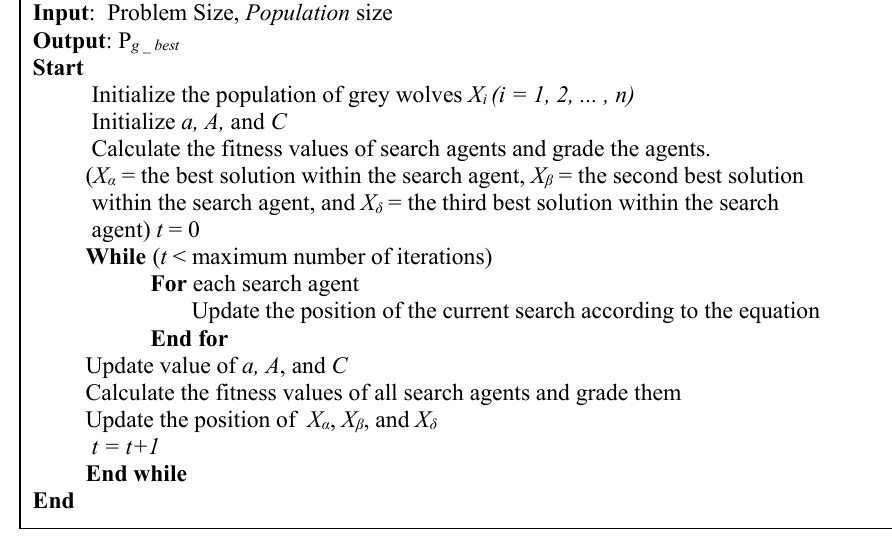
Fig. 2. Pseudo-code of grey wolf optimization algorithm